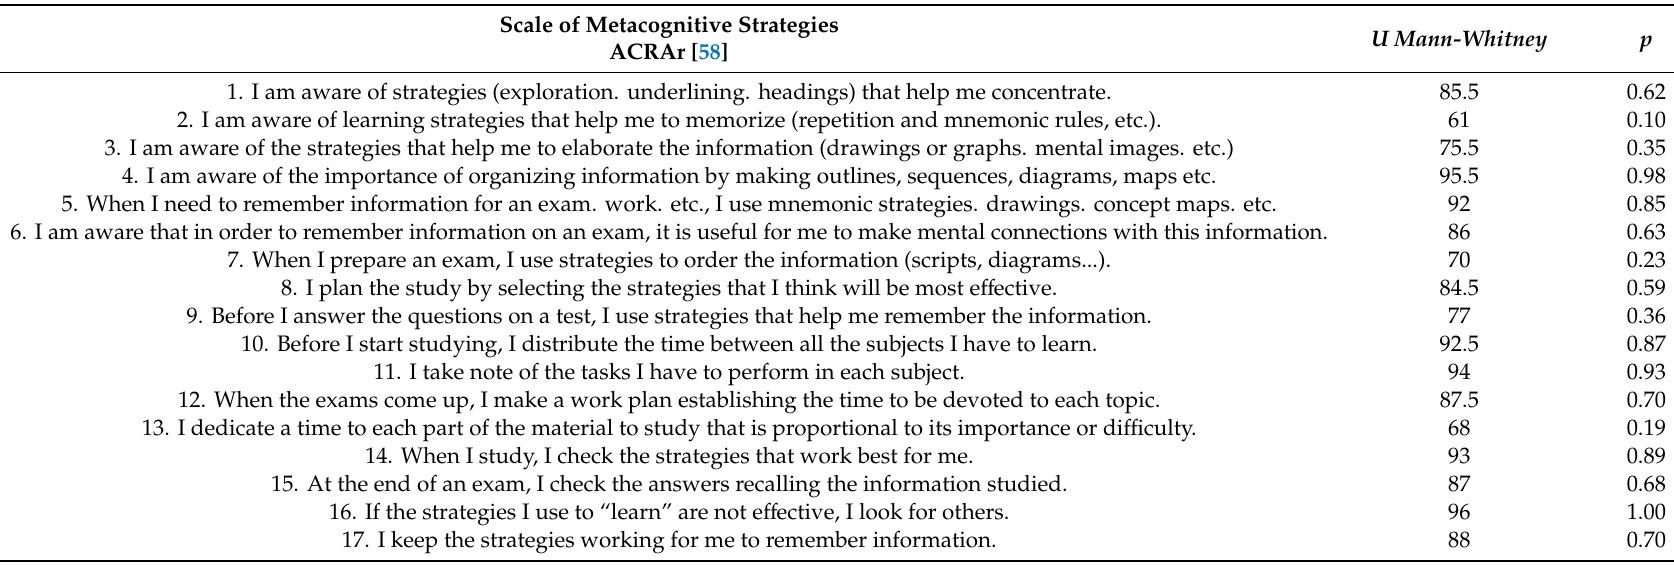
Table A1. Two independent samples test in parametric